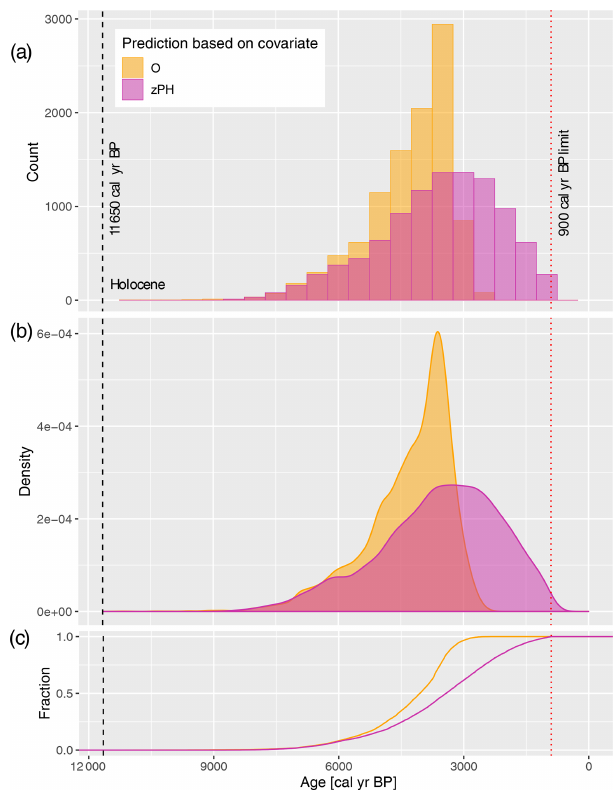
Figure 10. (a) Histogram of predicted peat initiation ages for Fochteloërveen, showing results for the prediction based on thick- ness of organic deposits [ O ] (see Fig. 8a) and for the prediction based on groundwater-fed wetness that results from geomorpholog- ical position [ z P H ] (see Fig. 8b). Start of the Holocene follows Walker et al. (2009). Temporal scope of the predictions runs to 900calBP. Note that certainty of both predictions is different (see standard deviation maps in Fig. 8a and b). (b) Density plot of pre- dicted peat initiation ages for Fochteloërveen (i.e. normalised to a graph surface area of one). (c) Plot showing cumulative fraction of peat-covered area within the Fochteloërveen area as indicated by the two